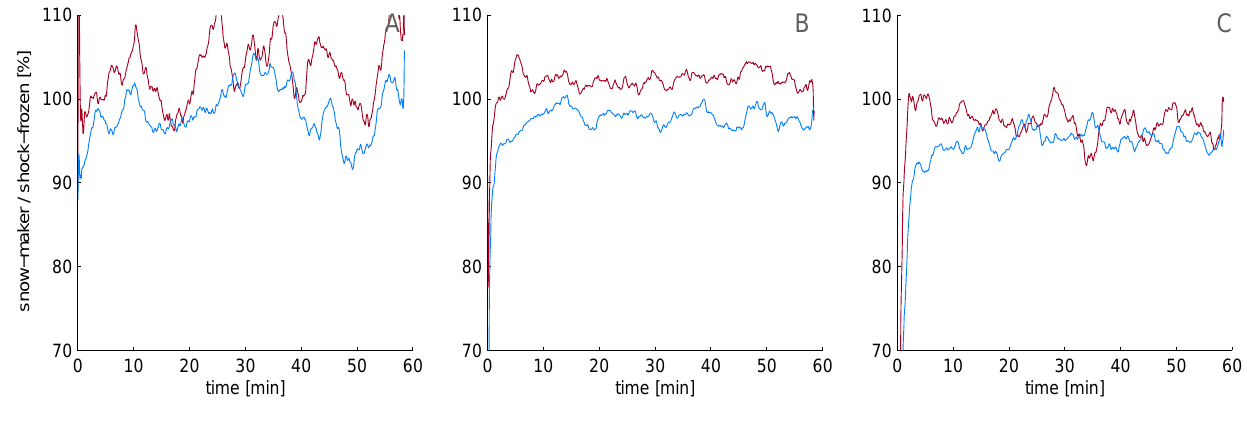
Fig. 4. Comparison of diffusivities in polycrystalline and single-crystalline samples. Shown is the ratio of the observed recovery profiles of methanol (blue) and acetone (red) at different temperatures ( (A) 263K, (B) 243K, (C) 223K) for a single-crystalline and polycrystalline sample.